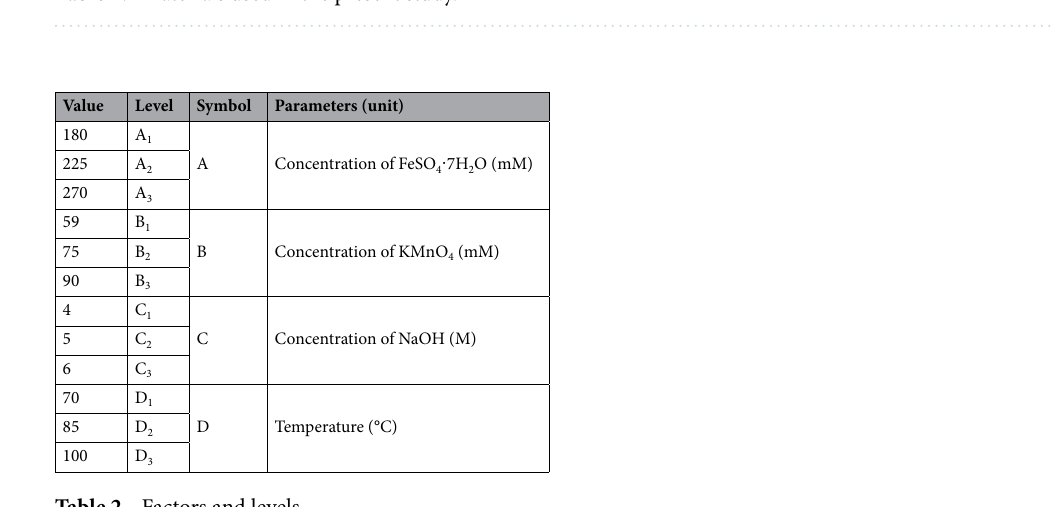
Table 1. Materials used in the present study.